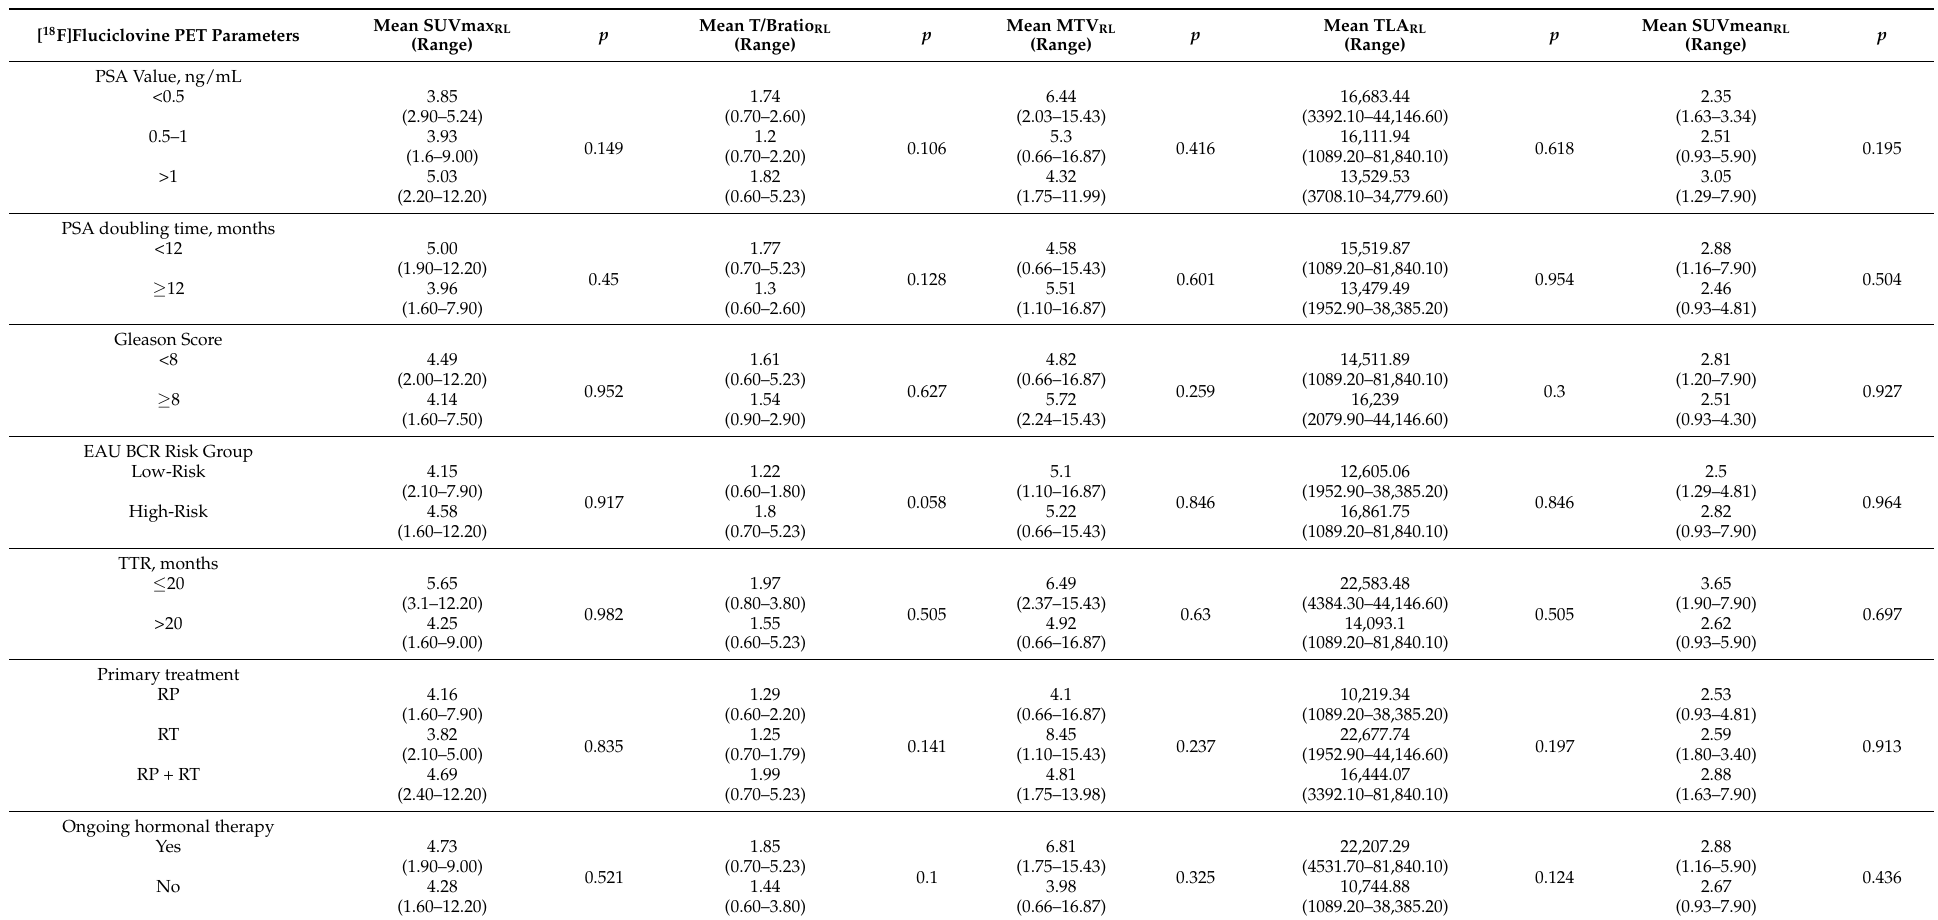
Table 3. Per-patient semiquantitative analysis in relation to biochemical and clinical–histological